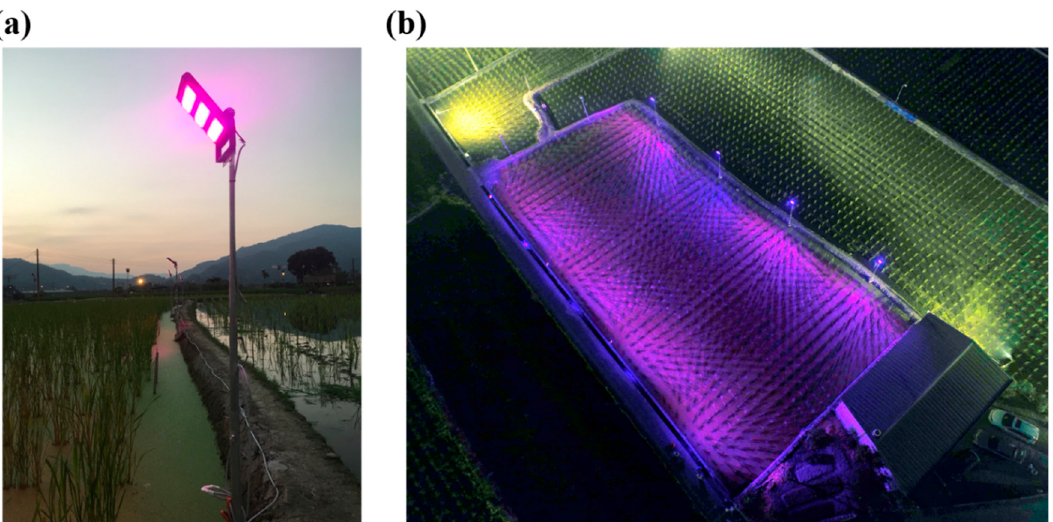
Figure 4. ( a ) Zoom-in image of LED lamp constructed near the ridge. ( b ) Water bamboo field with eight LED lamps switched on. The HPS lamps were used in the other field. Inhomogeneity of light coverage was observed in both fields. The ratio of red to blue LED bulbs inside the LED modules was 6: 1.